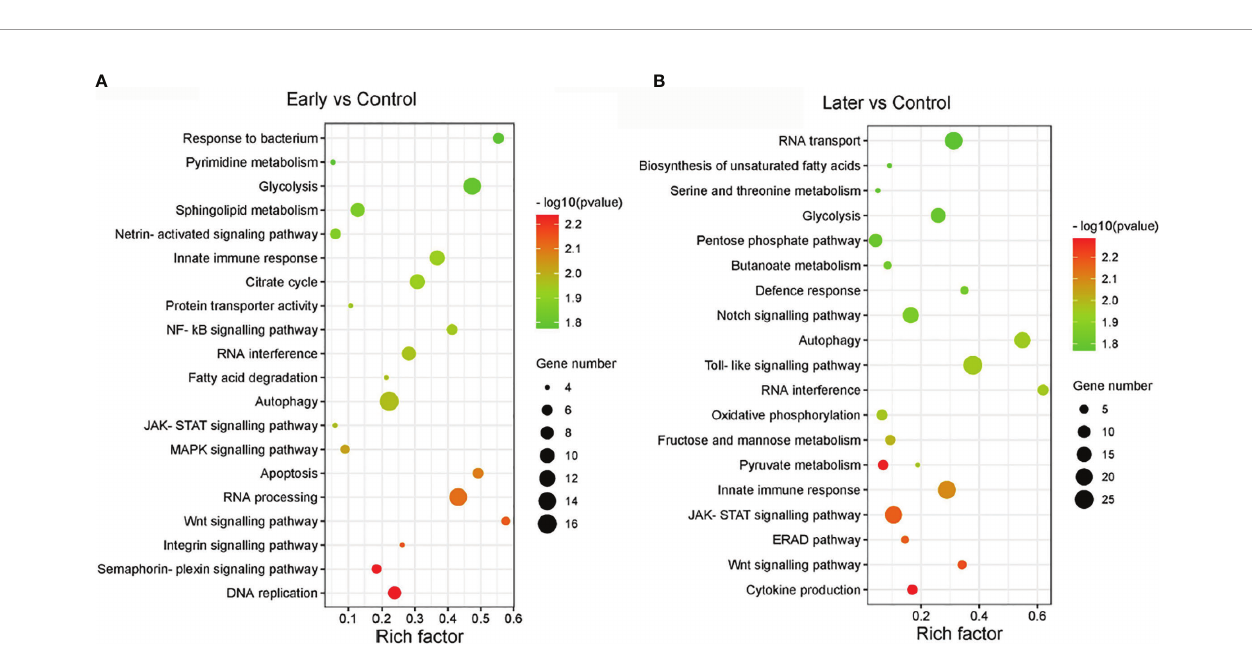
FIGURE 4 | The enriched KEGG pathwaysof differentially expressed lncRNAs. (A,B) KEGG analysisofdifferentially expressed lncRNAs with high enrichment score. (A) between uninfected and early infectedgroup, (B) between uninfected andlater infectedgroup. The sizeof thecirclerepresented the number of genes, red to green indicated that the corrected P-value isgradually becomingsmaller.The degree of KEGG enrichment isassessed by theRich factor,P-value, and Gene number.